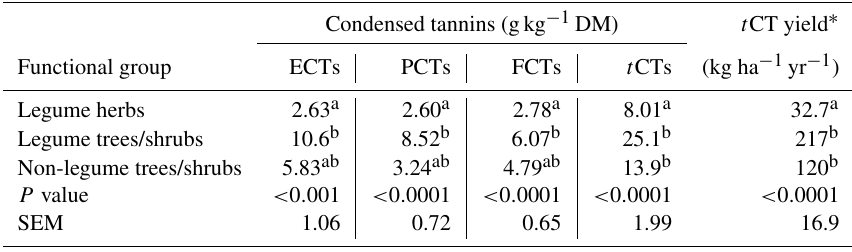
Table 3. Condensed tannin (CT) profile and CT yield from three plant functional groups growing at the experimental site.